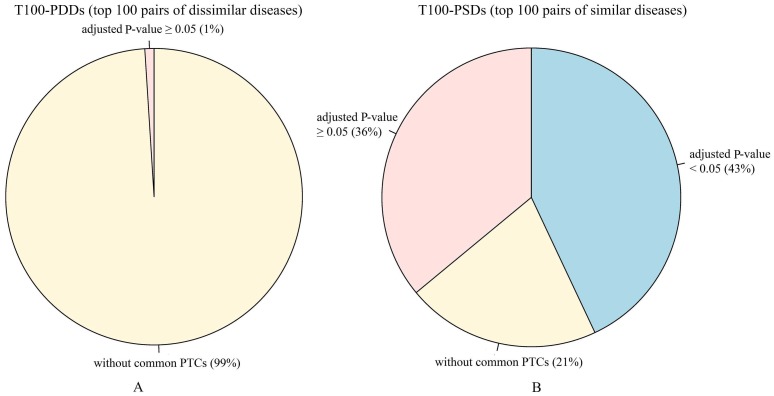
The number of pairs of diseases identified using SemFunSim with common PTCs.A. The number of pairs of the T100-PDDs with common PTCs. B. The number of pairs of the T100-PSDs with common PTCs. The yellow area represents the number of pairs without common PTCs. The pink area indicates the number of pairs with common PTCs and adjusted P-value ≥0.05. The light blue area represents the number of pairs with common PTCs and adjusted P-value <0.05.